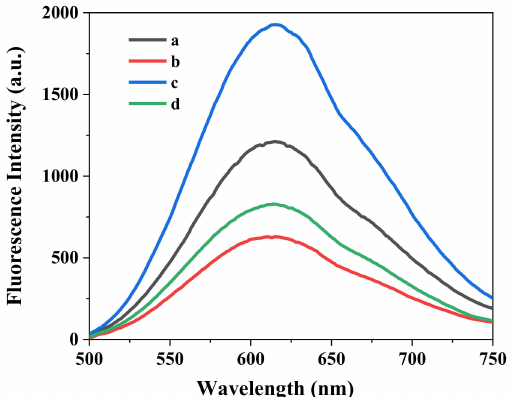
Figure 2. Fluorescence spectra of GSH-AuNCs and GSH/ β -CDs-AuNCs in the absence and presence of paraquat. a, GSH-AuNCs; b, GSH-AuNCs in the presence of 500 ng/mL paraquat; c, GSH/ β -CDs- AuNCs; d, GSH/ β -CDs-AuNCs in the presence of paraquat.